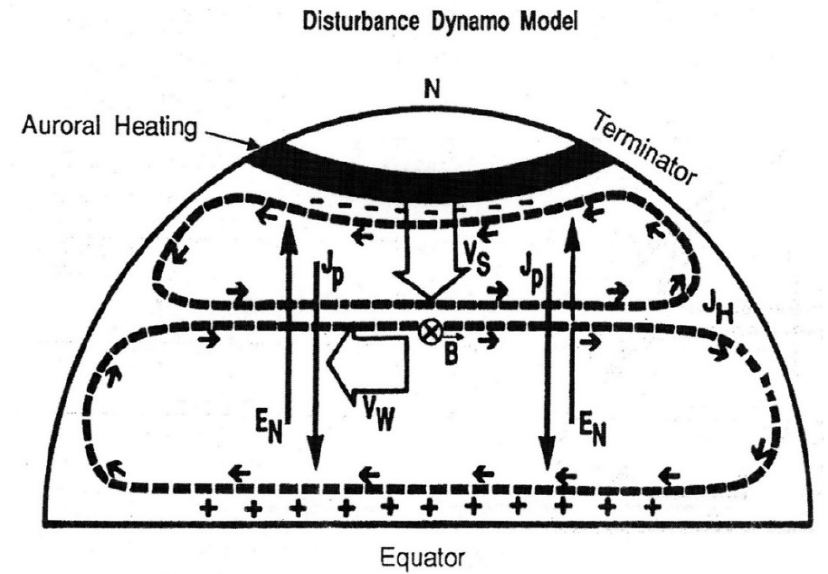
Figure 7. Disturbance dynamo model [7].